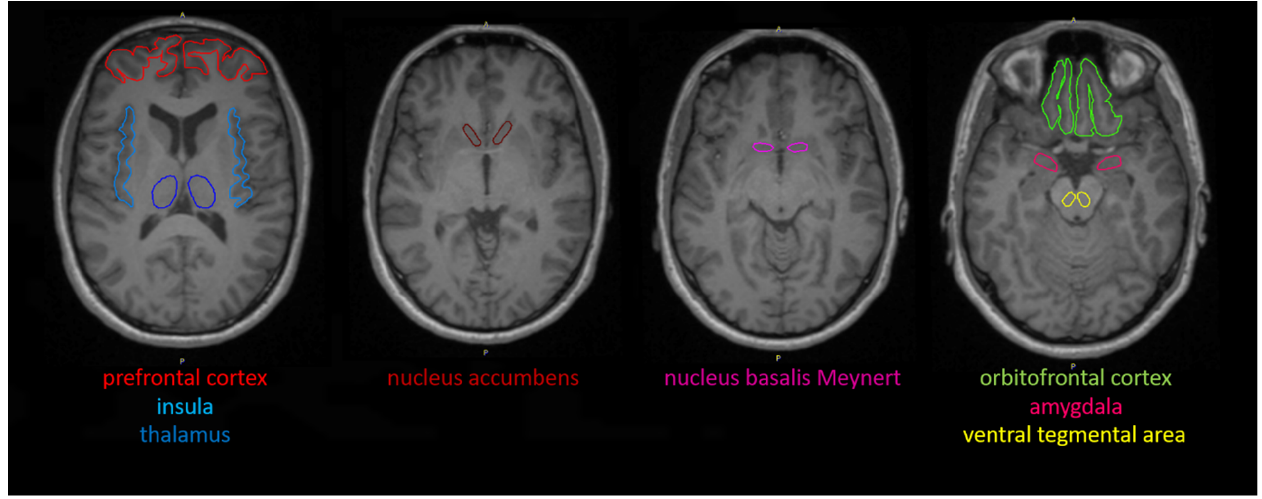
Figure 1. Manually drawn, anatomical ‐ based volumes of interest defined in individual transaxial magnetic resonance imaging data sets (same text color was used for the specific brain region in each slice).